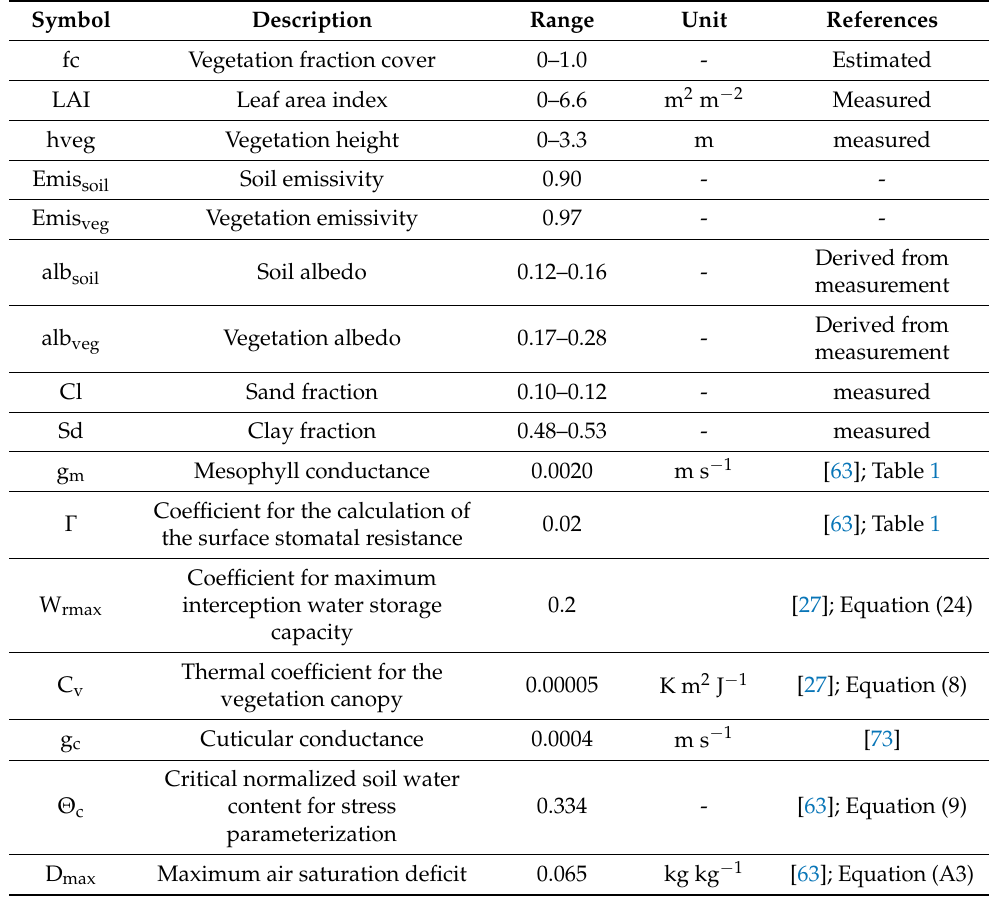
Table 2. Values and ranges of the input variables for ISBA and ISBA-MEB using the Ag-s photosyn- thesis option.